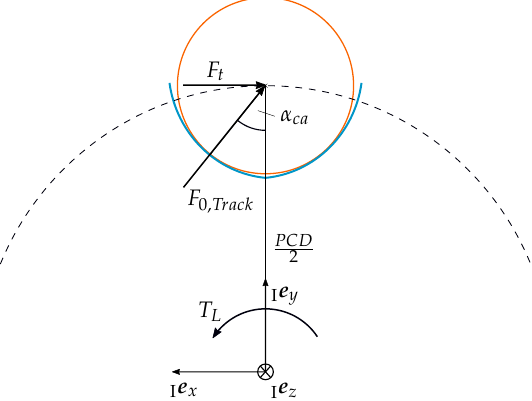
Figure 9. Calculation of the analytical contact